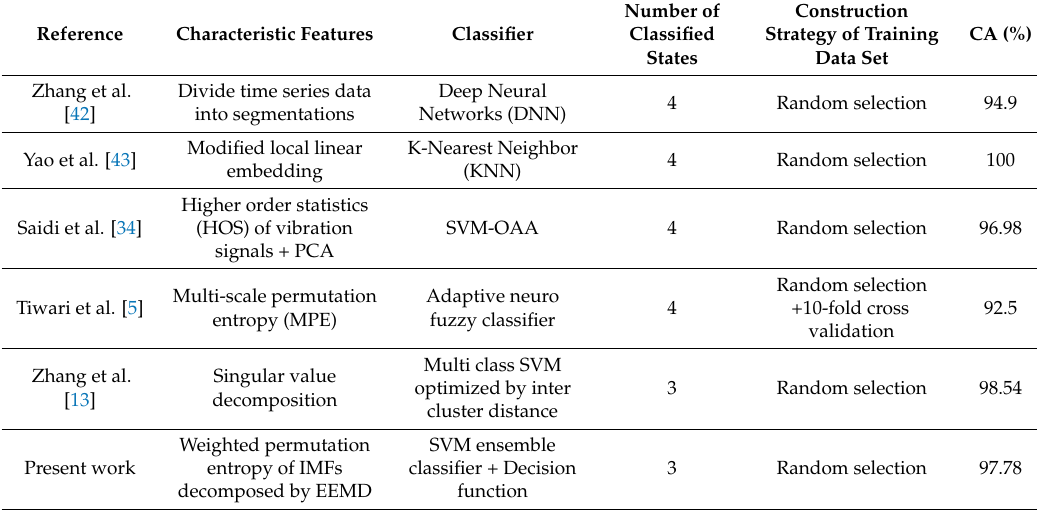
Table 5. Comparisons between the present study and some published